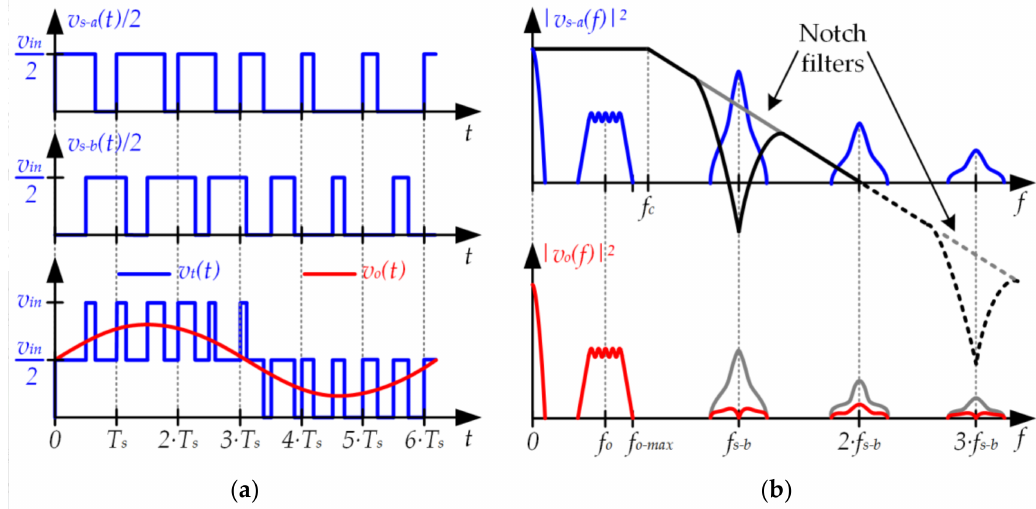
Figure 12. ( a ) Pulse-width modulator using two identical pulse voltage waveforms but with 180 ◦ out of phase; ( b ) Reduction of the switching-related harmonics.